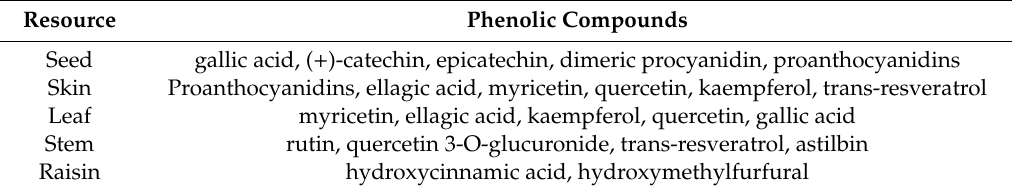
Table 2. The phenolic compounds in di ff erent parts of grape and its products. Adapted from [39].